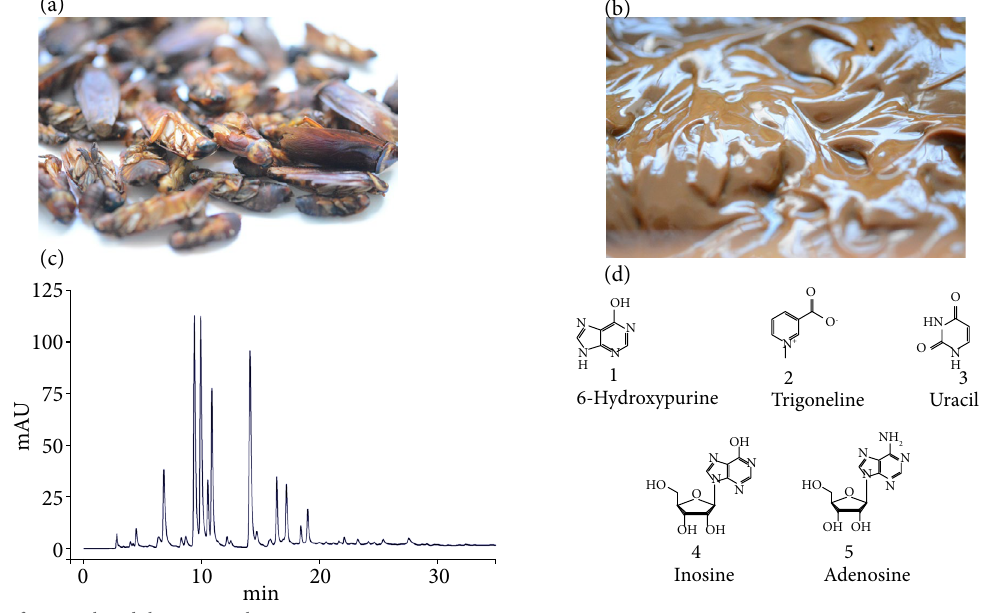
Figure 2 - HPLC analysis of Periplaneta americana L., xanthine, hypoxanthine, inosine, uracil, and uridine. (a) The dried insect body of P. americana L. (b) Ethanol extract of P. americana L. (c) HPLC fingerprint chromatogram of Periplaneta americana L. (d) Peaks